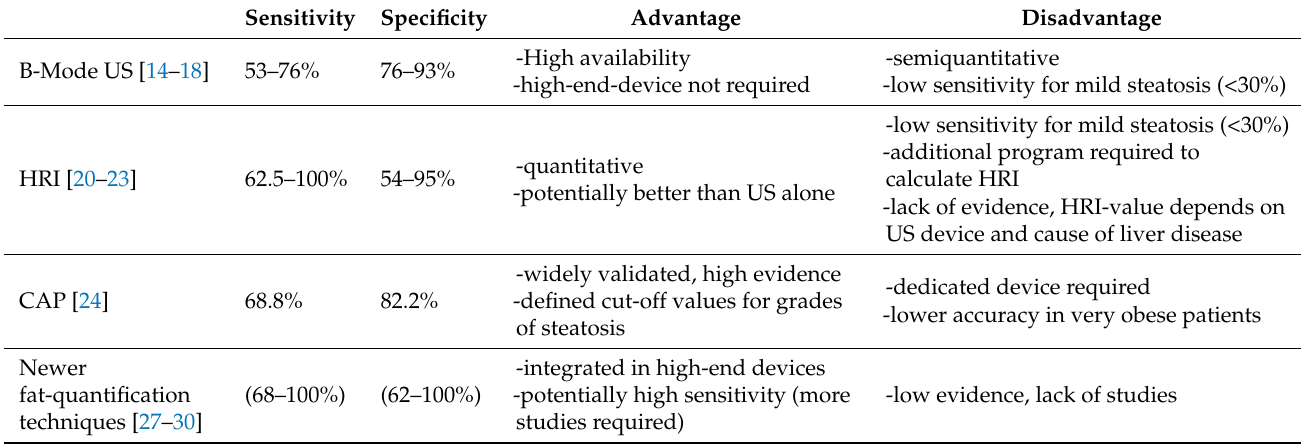
Table 1. Shows the performance of diagnostic tools for detection of steatosis and their advantages and